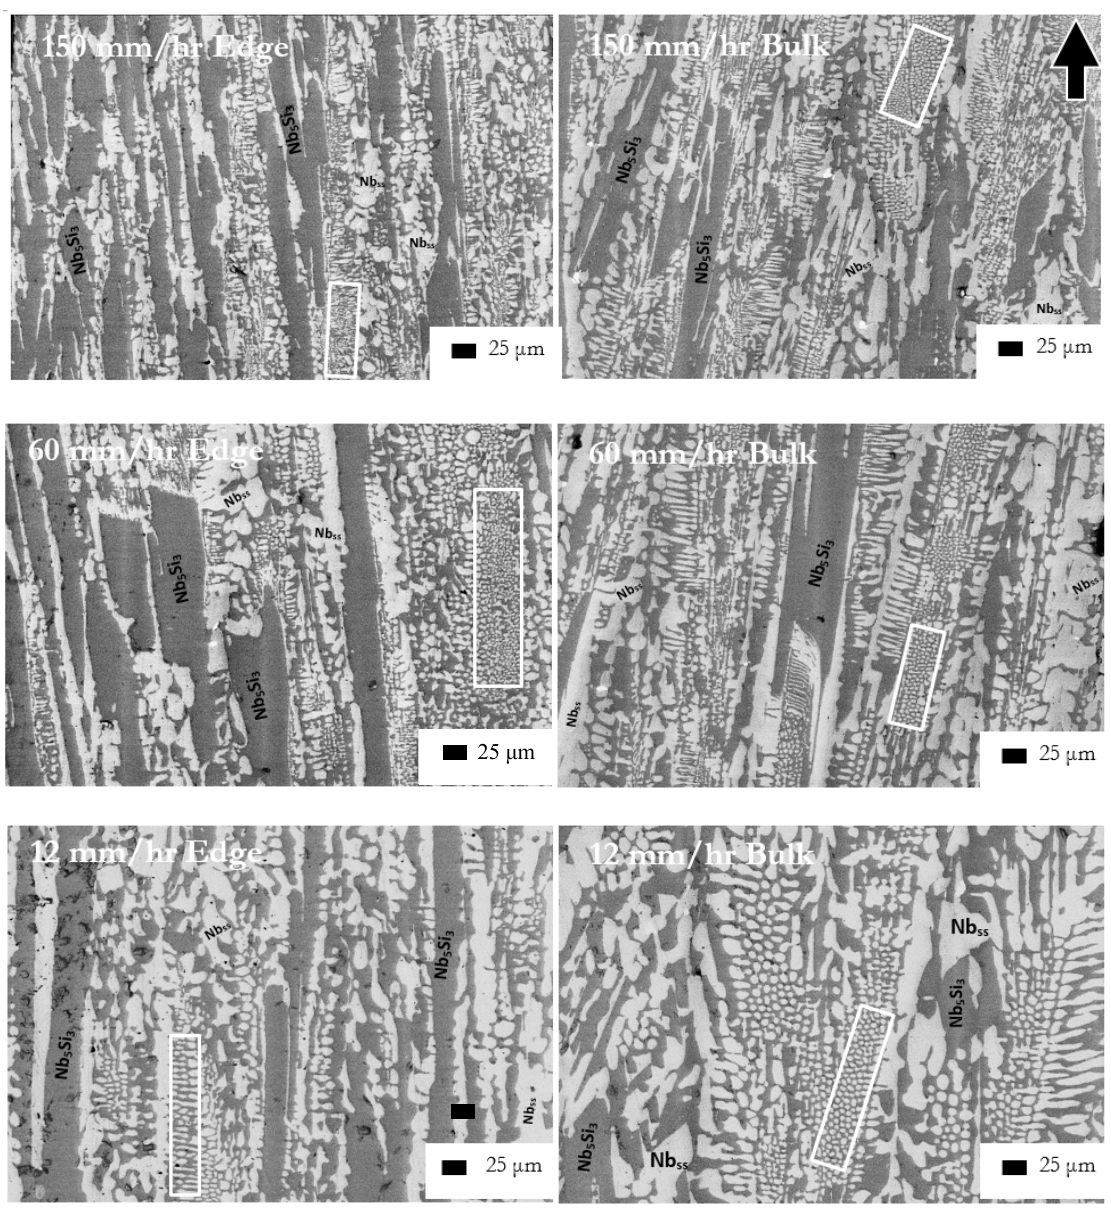
Figure 3. BSE images of CM1-OFZ processed at 150 mm/h, 60 mm/h and 12 mm/h, respectively from top to bottom. Left hand images show the microstructure at the edge of the bar and right hand images show the bulk microstructure. The arrow indicates the growth direction. Rectangles show lamellar microstructure.